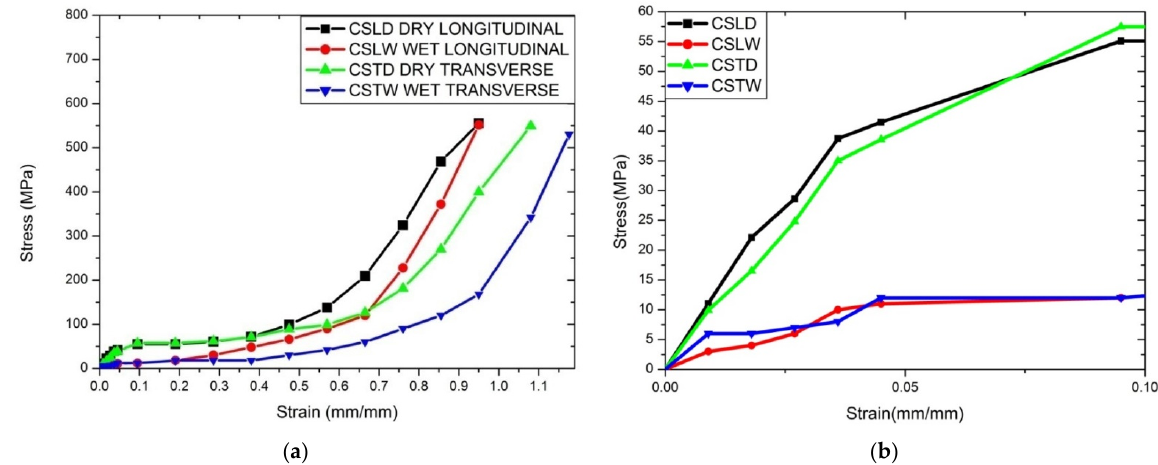
Figure 10. ( a ) Compression stress–strain curve for all the specimens and ( b ) compression stress–strain curve for the closure image.